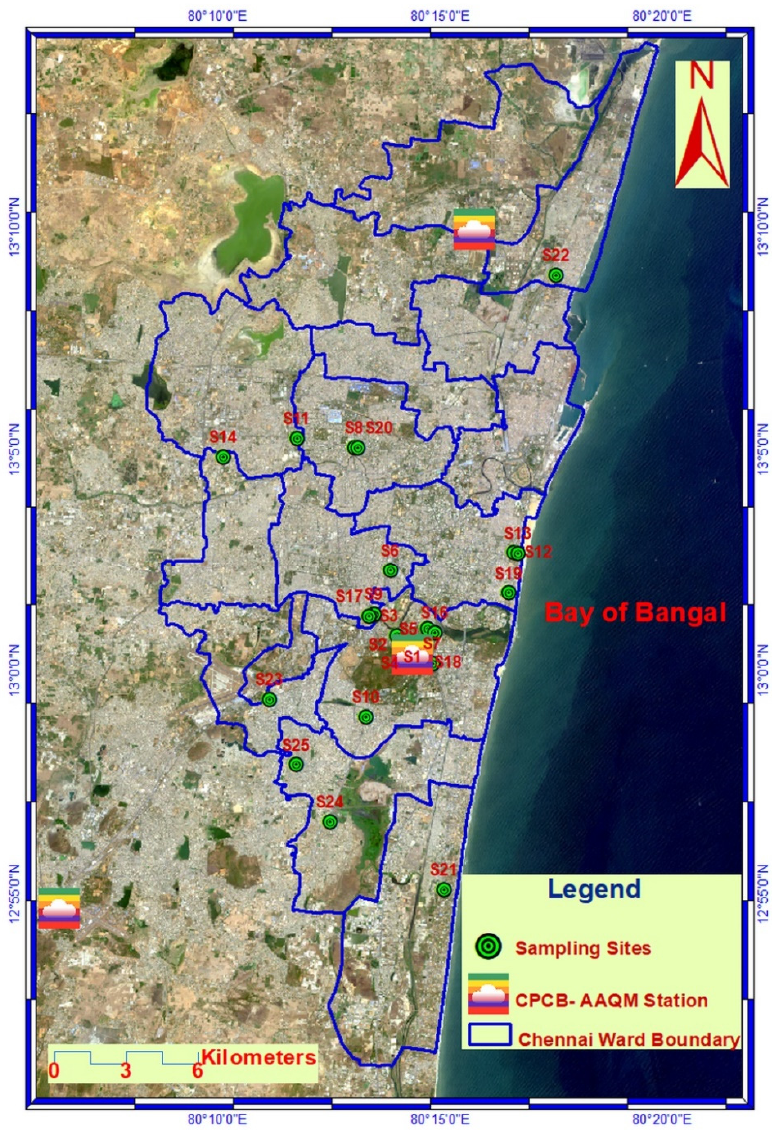
Figure 1. Study area with sampling sites of Chennai urban zone, South India.